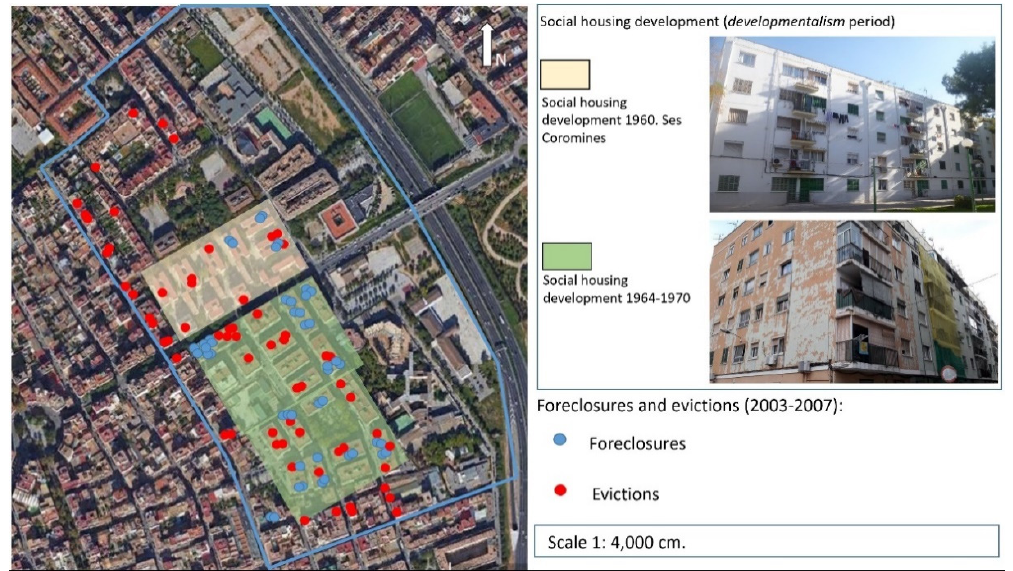
Figure 6. Typologies of social housing, evictions, and foreclosures in Son Gotleu